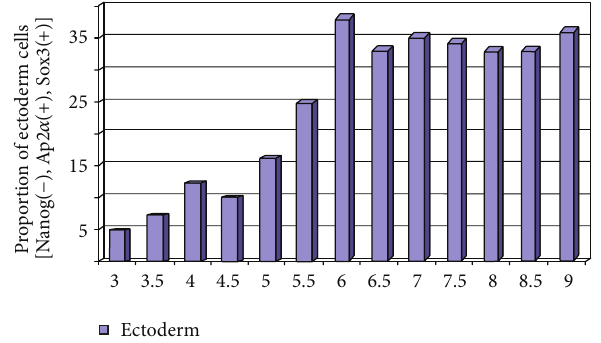
Figure 5: Possible outcome for ectodermal differentiation. In this example, using the differentiation markers AP2a and Sox3, the predicted peak for differentiation would be day 6, with a standard deviation of 3 days. The analysis should be done in 12-hour